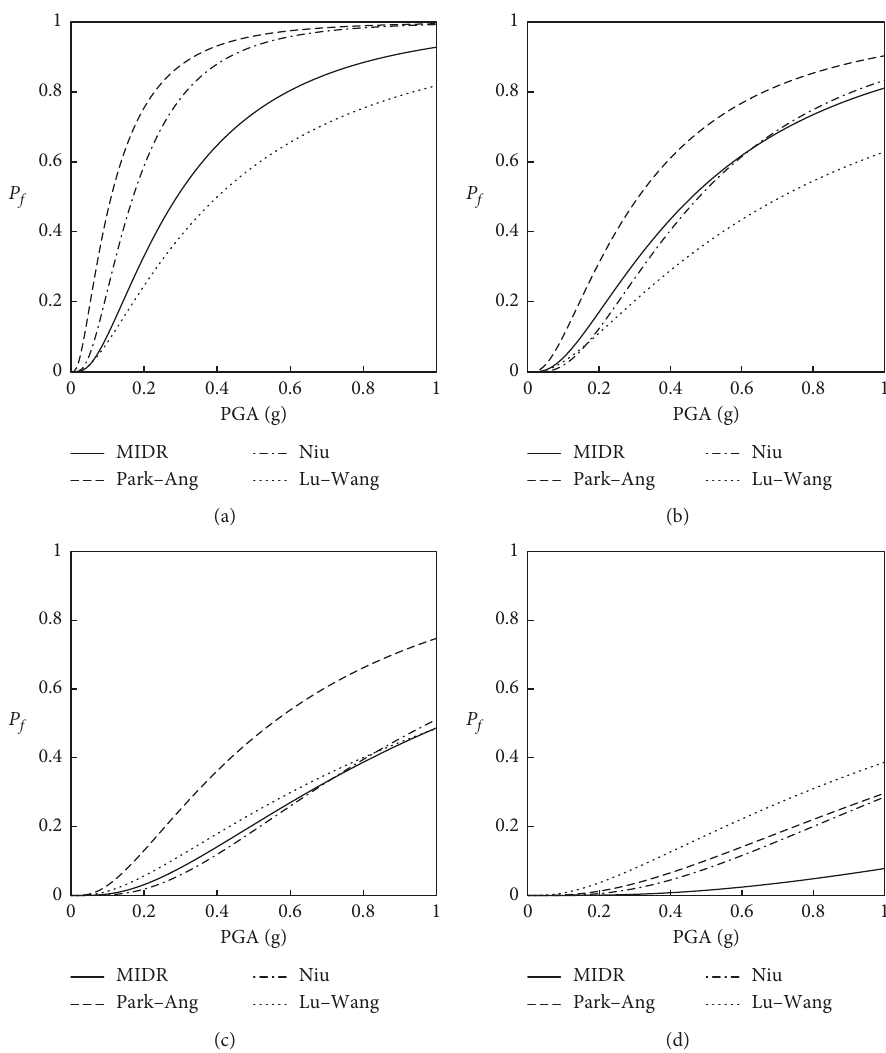
Figure 10: Fragility curves of the fixed-base building based on DPDMs compared with the MIDR damage index: (a) slight damage, (b) moderate damage, (c) severe damage, and (d) complete damage. Table 7: Parameters of the fragility functions in terms of PGA-MIDR for the analysed structure with and without SSI effect. Median PGA RC buildings